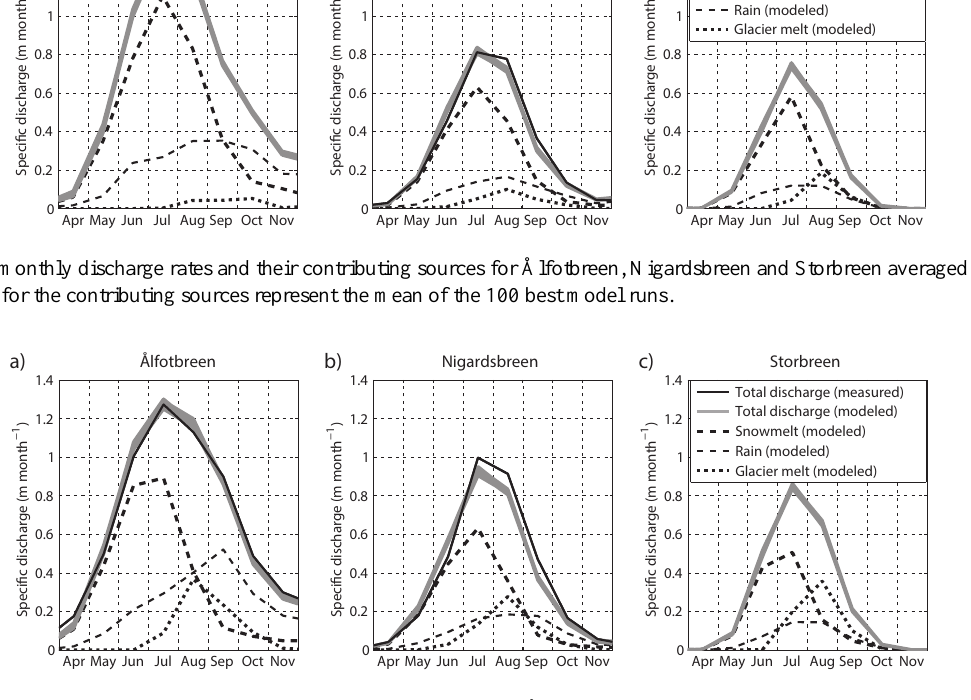
Fig. 9. Modelled monthly discharge rates and their contributing sources for ˚Alfotbreen, Nigardsbreen and Storbreen averaged for the period 1991-2000. Data for the contributing sources represent the mean of the best 100 model runs.